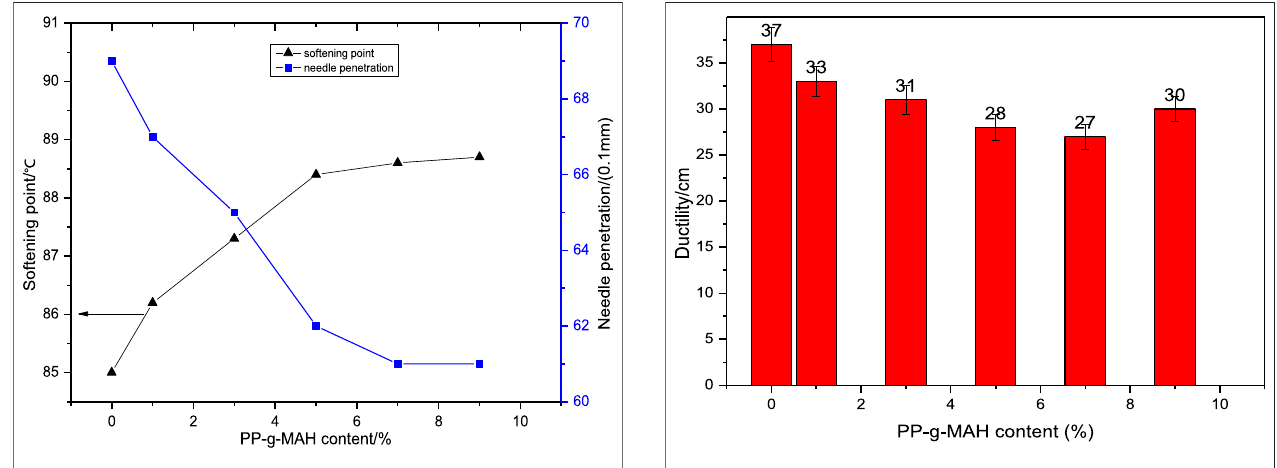
FIGURE 3 | Effect of PP-g-MAH content on the softening point and penetration of modi fi ed asphalt.